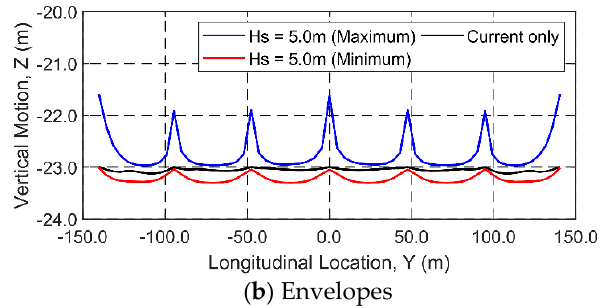
Figure 9. Time histories of the vertical motions of the net at the top-middle location (Y = 0 m, Z = − 23 m) in different wave conditions ( a ) and motion envelopes along the net length at H s = 5.0 m and T p = 10.0 s ( b ) (current velocity = 0.6 m/s).